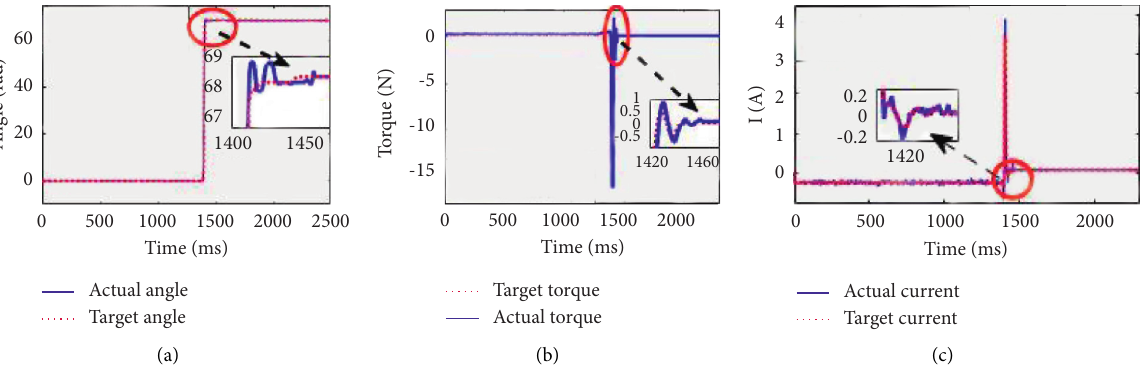
Figure 13: Response curve under step signal. (a) Angle contrast curve. (b) Torque contrast curve. (c) Current contrast